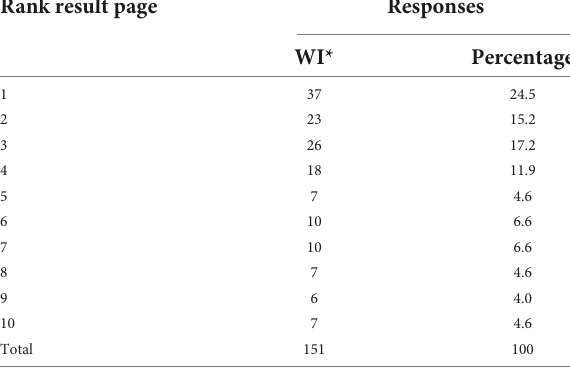
TABLE 5 Rank of WI on the result